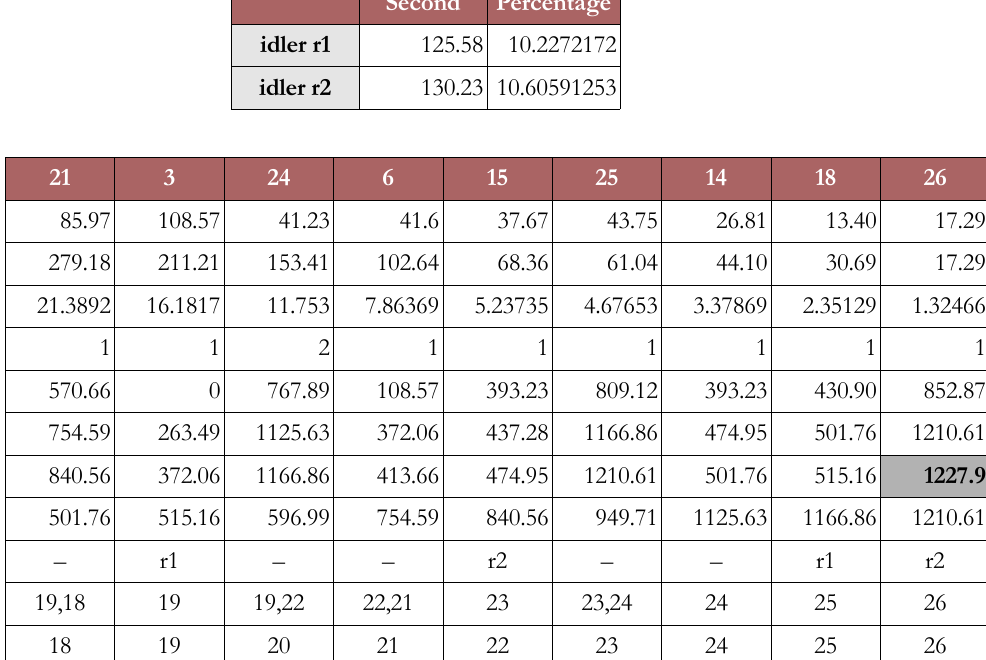
Table 14. TIMRES Scheduling, Rmax = 2, n(r) = 2 (Scenario